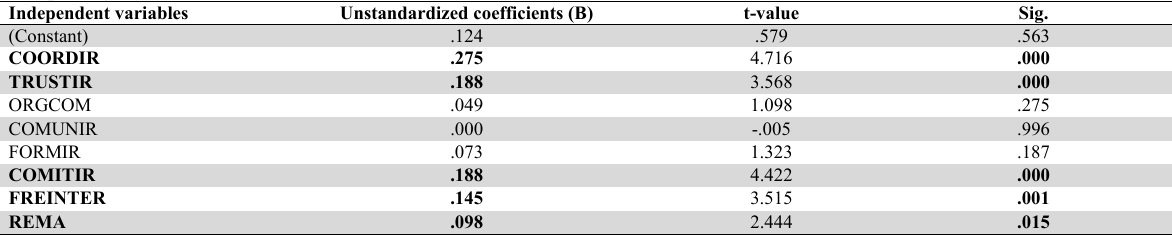
Multiple regression coefficients analysis for H2 Independent